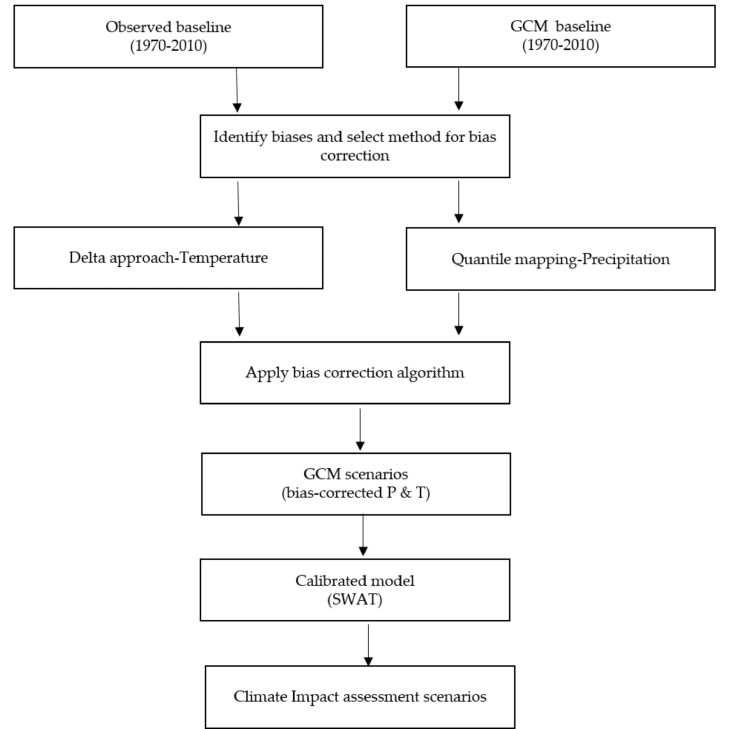
Figure 2. A flow chart describing the analysis completed to assess climate change impact on the Goodwater Creek Experimental Watershed using historical weather observations, CMIP5 climate data, and